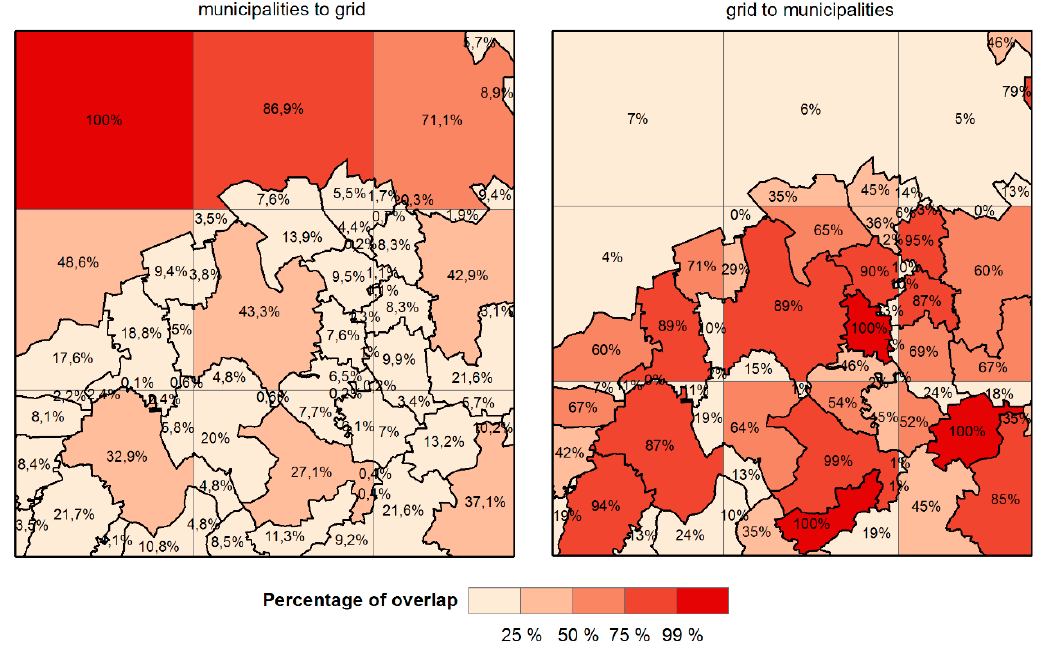
Figure 1. Calculations of the percentage of overlay the degree of fit, municipalities-to-grid and grid-to-municipalities directions. Source: © EuroGeographics for the administrative boundaries, European Commission, Eurostat/GISCO.